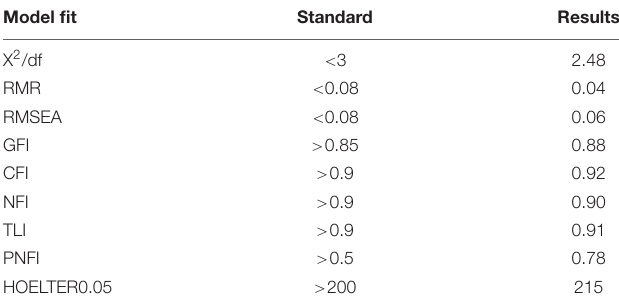
TABLE 3 | CFA results of the model. Model variance